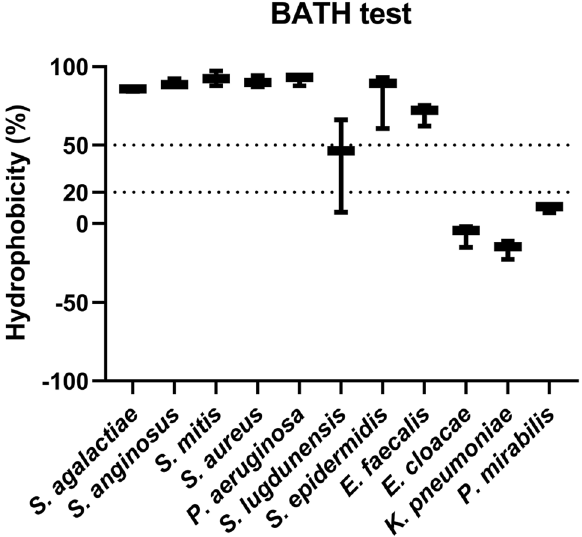
Figure 5. BATH tests for cell surface hydrophobicity. The bacterial adhesion to hydrocarbon (BATH) test was performed to measure each microorganism’s cell surface hydrophobicity (%). The experiments were repeated at least three times for each microorganism.